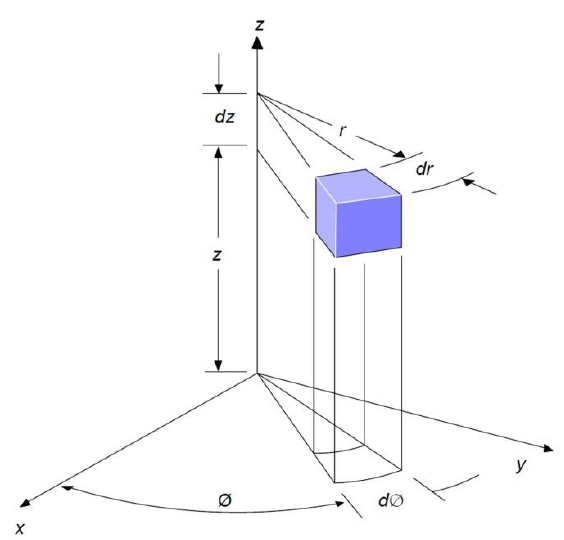
ff erential volume element in cylindrical coordinates Figure 5. A differential volume element in cylindrical coordinates [30]. Figure 5. A di